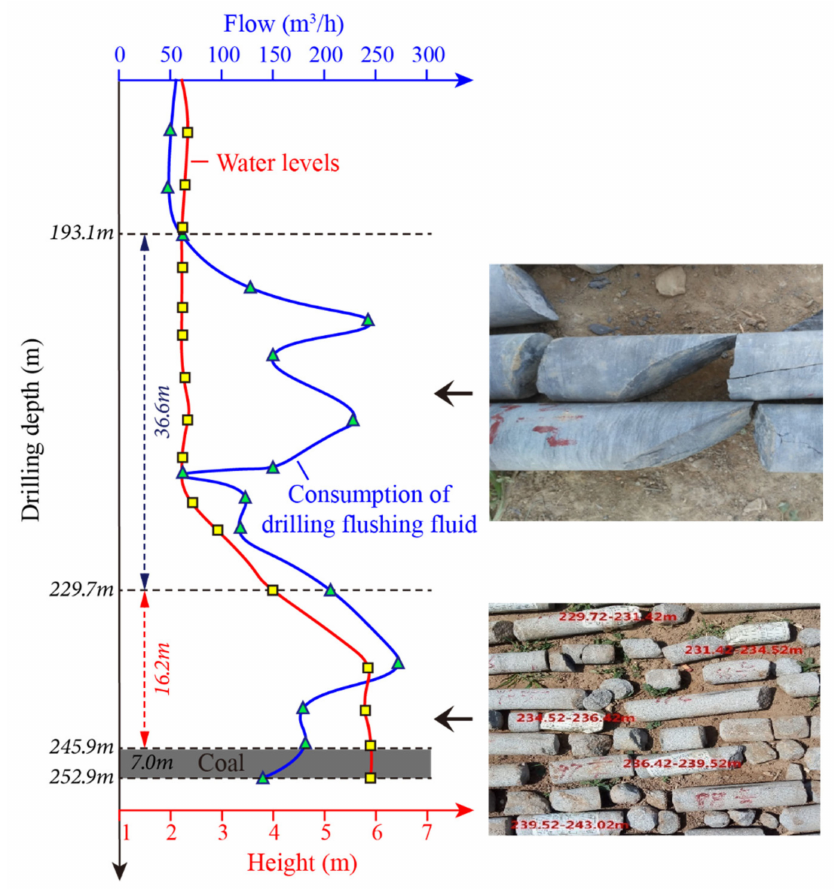
Figure 6. The variation in water level, consumption of drilling flushing fluid and core fracture characteristics with